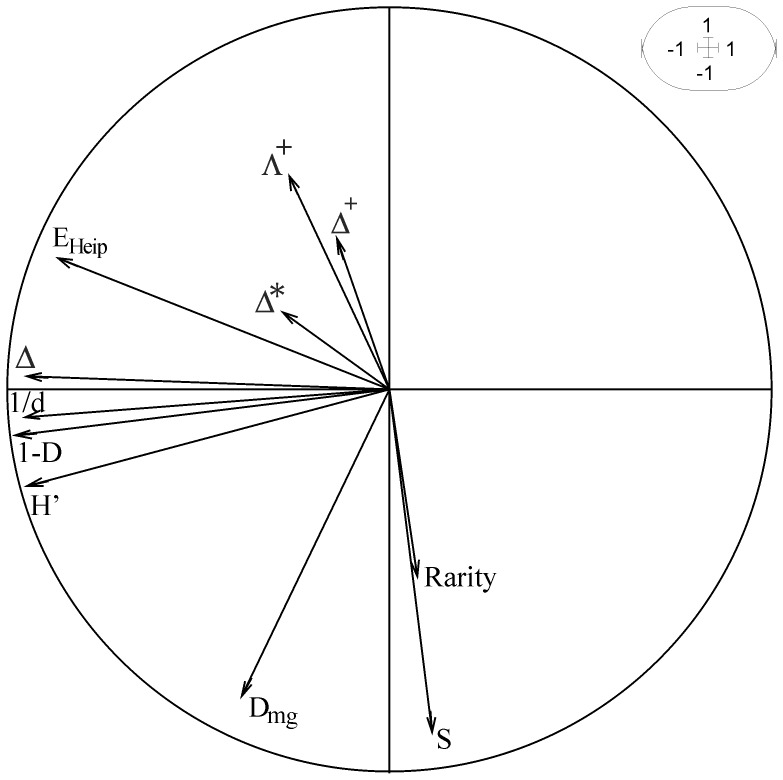
Projection of the diversity indices onto the first factorial plan of the PCA.(axis 1: horizontal –43%, axis 2: vertical –22%). Codes of diversity indices are given in Table 1.